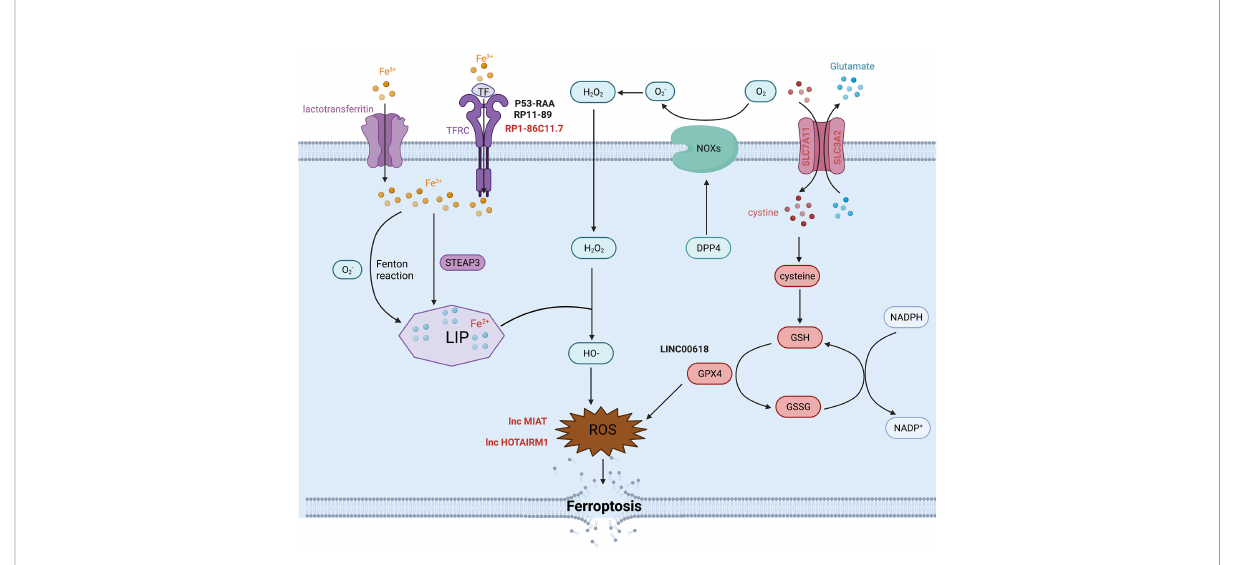
FIGURE 2 The molecular mechanism and some lncRNAs regulation of